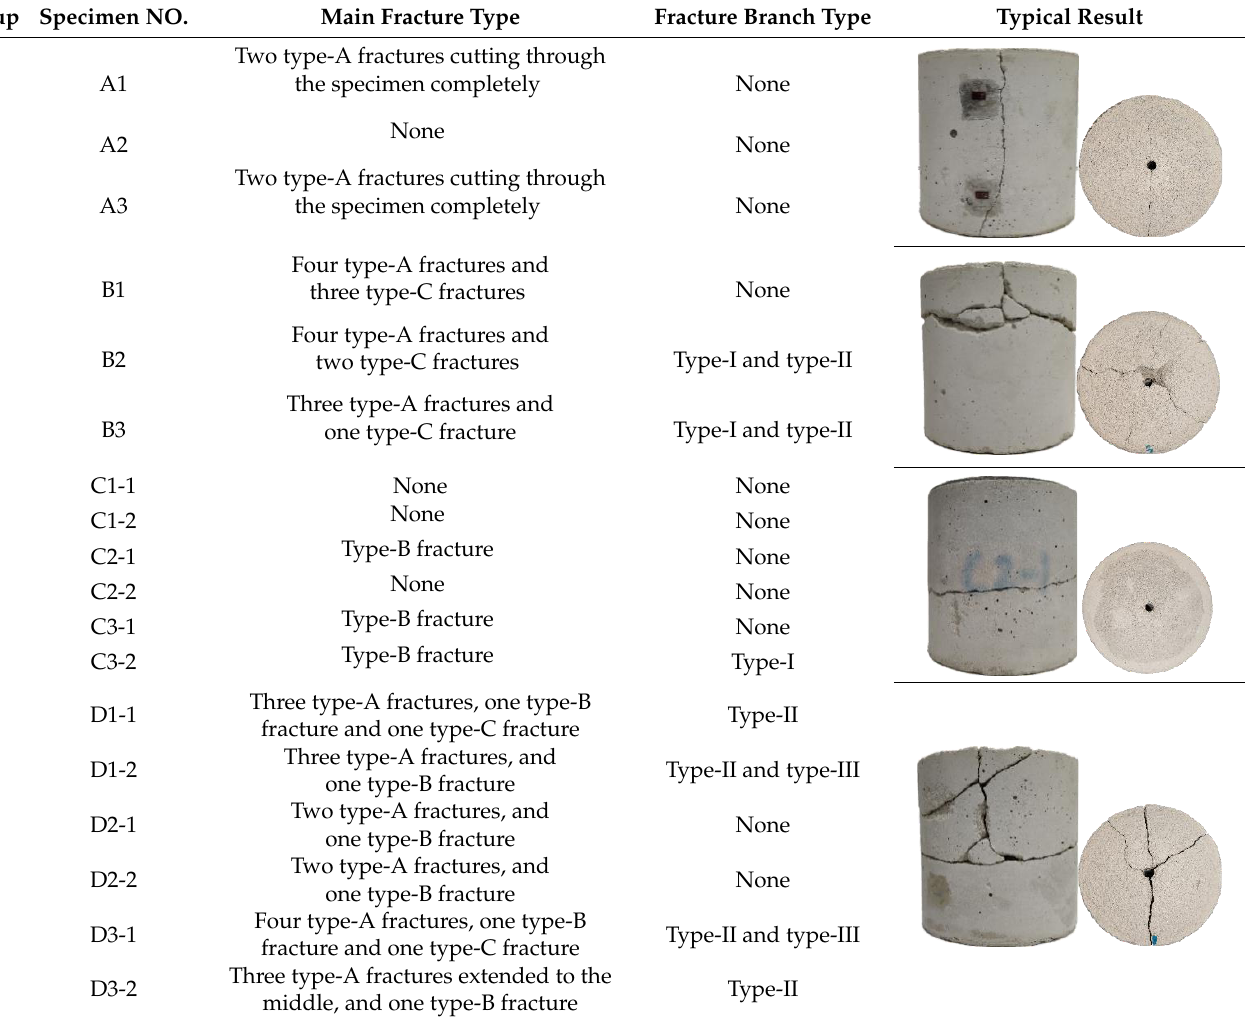
Table 4. The fracturing results of each specimen. Group Specimen NO.